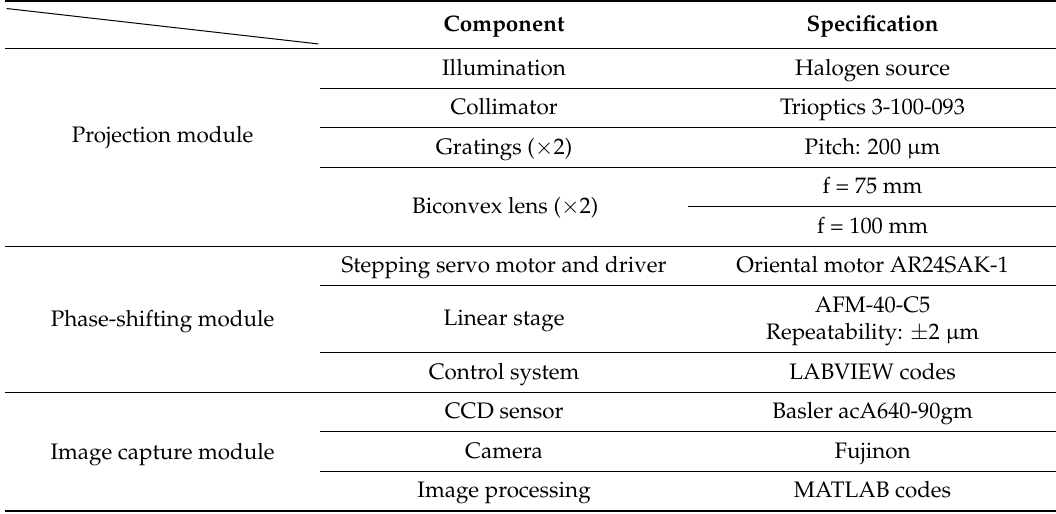
Figure 3. Photo of the experimental setup of the projection moiré system. Table 1. Components of the measurement system.